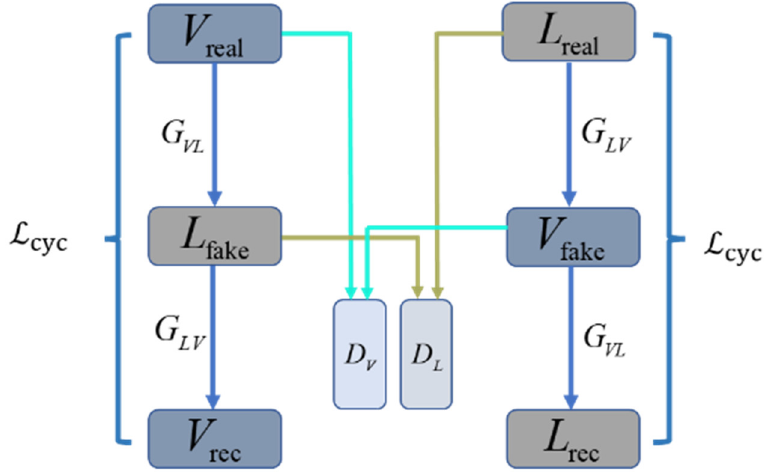
Figure 6. CycleGAN network structure.